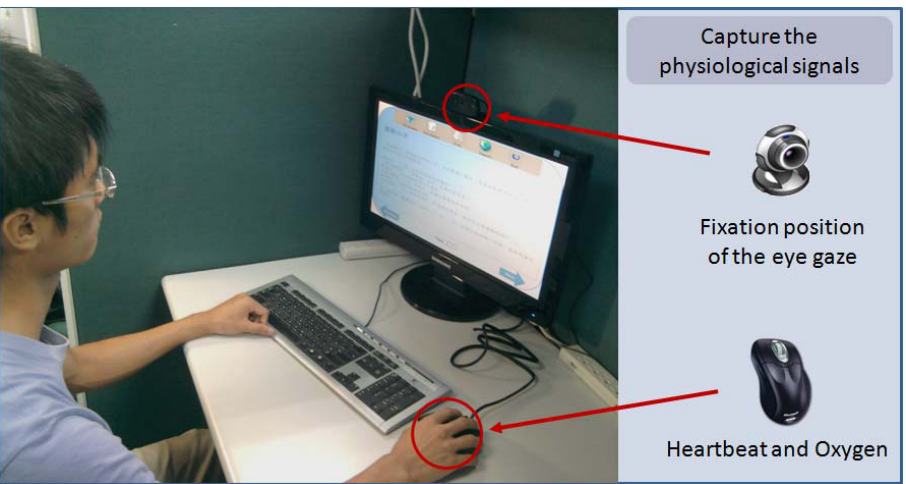
Figure 5. A student using the proposed system.